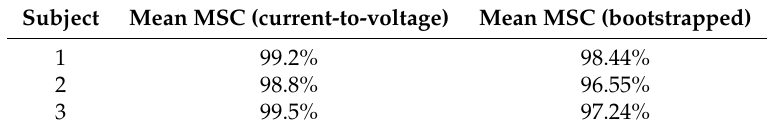
Table 2. Values of the mean of the MSC values obtained from contact acquired, Paynter filtered EMG